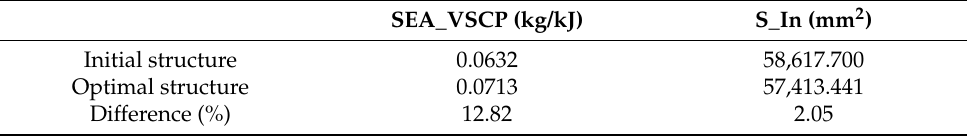
Table 9. Difference between the optimal structure and initial